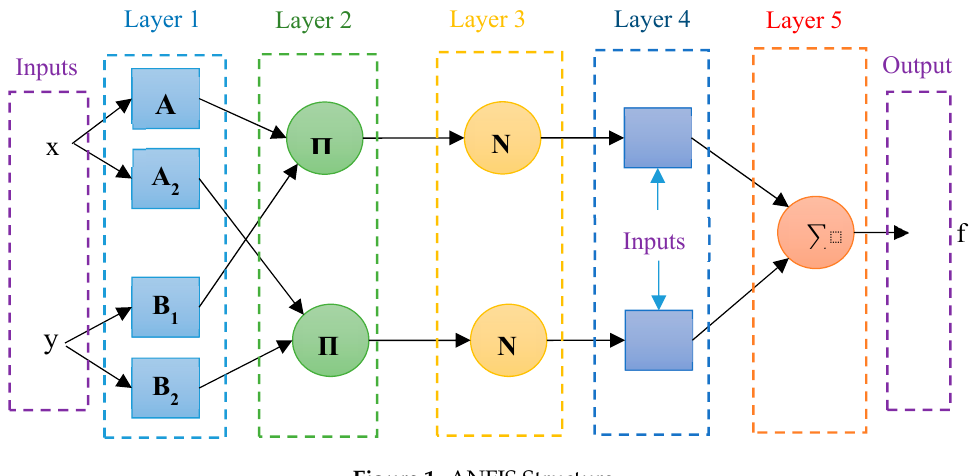
Figure 1. ANFIS Structure.